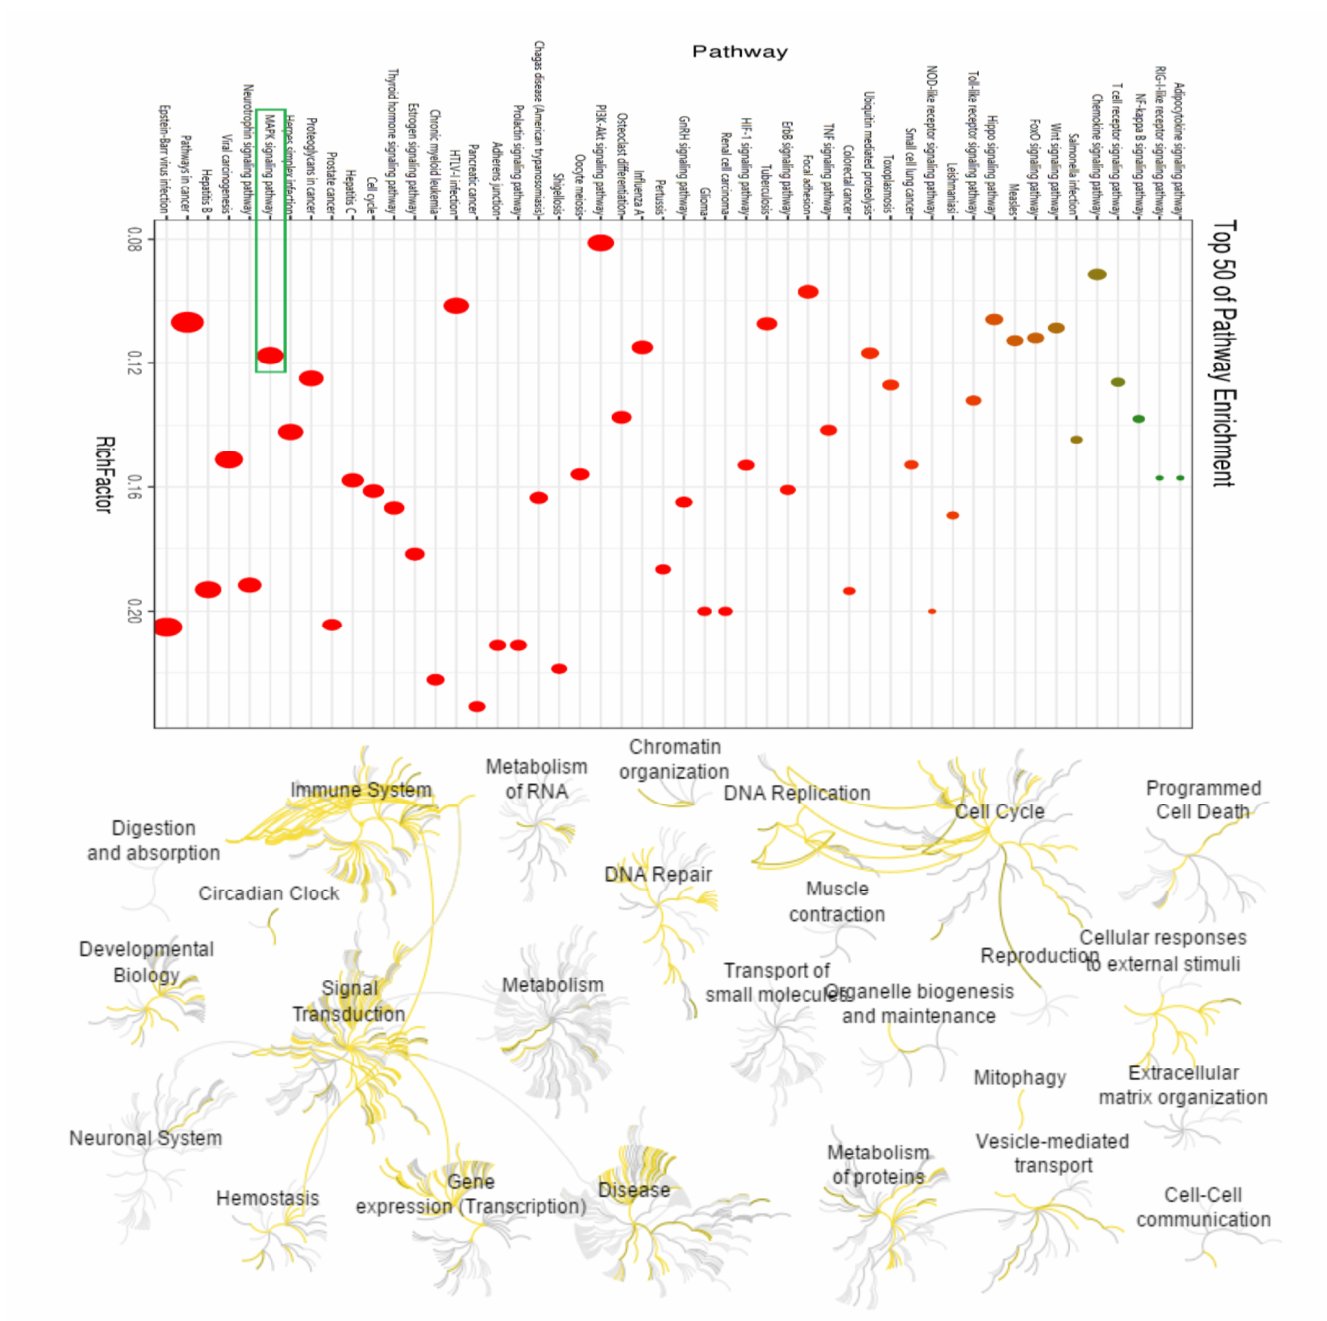
Fig 3. Distribution and the bubble map of core pathways. Note: (A.) The vertical axis is the path name and the horizontal axis is the Rich Factor value. The larger the P-value, the higher the channel enrichment; the size of the point indicates the number of enriched targets; the color of the dots is red to green. The value is from small to large. (B.) The yellow to brown pathway lines represent the pathways for important target enrichment, from yellow to brown indicating that the pathway P-values are small to large. cell injury compared to others. In accordance with the results of cells, the order of hepatotoxic- ity by potential liver injury components may be diosgenin, rutaecarpine, evodiamine, tetran- drine, saikosaponin D and baicalin. The specific composition information was shown in S1